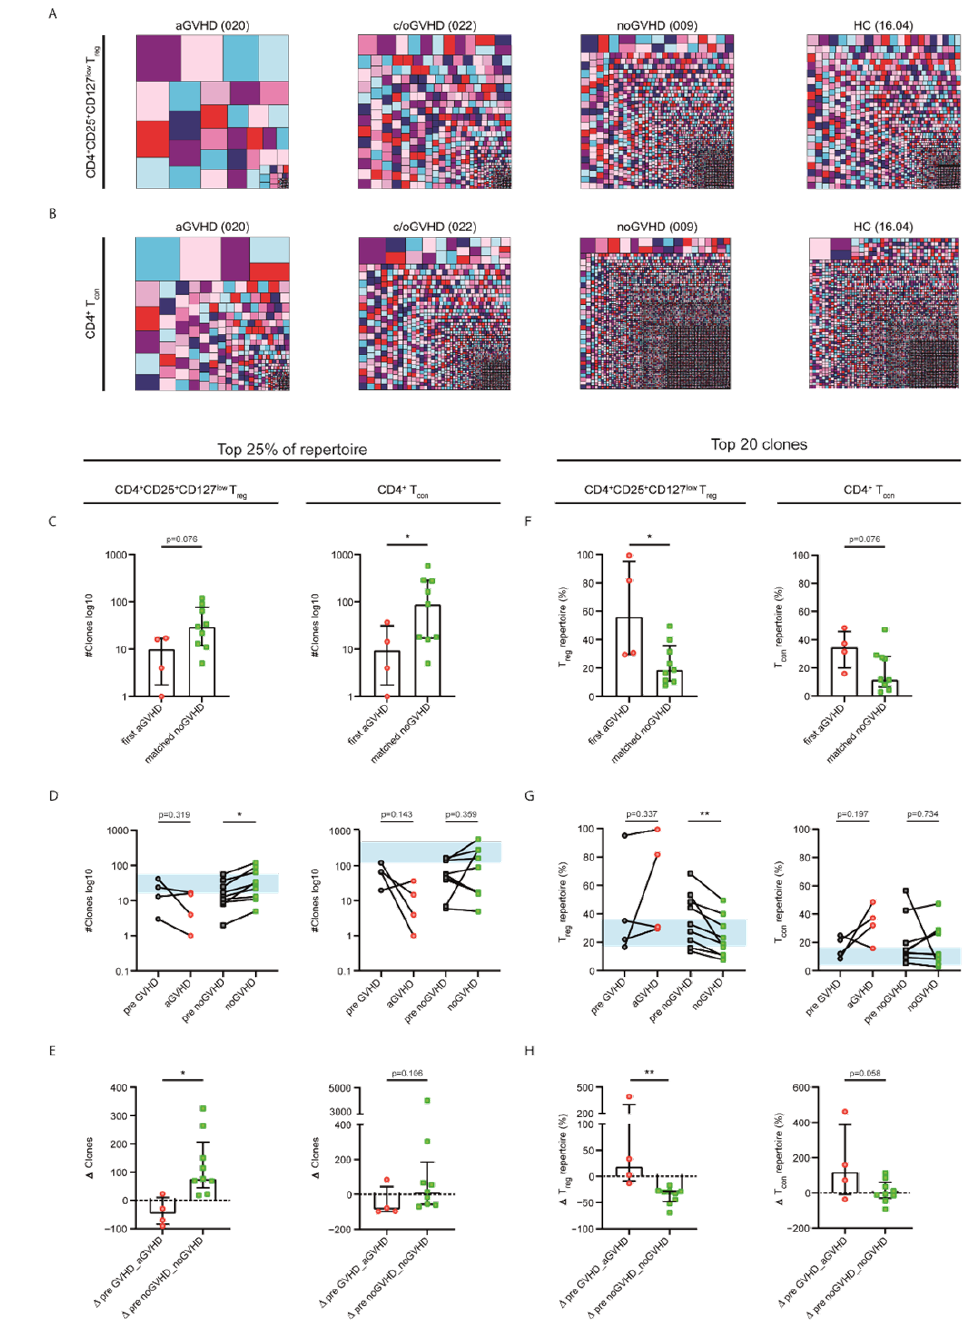
Figure 4. Increased clonality in the CD4 + CD25 + CD127 low T reg and CD4 + T con compartments is Figure 4 associated with aGVHD . ( A , B ) Tree maps visualizing the CD4 + CD25 + CD127 low T reg ( A ) and the CD4 + T con ( B ) repertoire proportions of four representative patients for aGVHD, c/oGVHD, noGVHD and healthy controls (patient IDs in parentheses). Each clone is represented by a randomly colored square with its size representing the individual clone’s proportion to the repertoire. Repetitive colors do not represent identical clones. ( C ) Numbers of unique clonotypes (y-axis) required to occupy 25% of the CD4 + CD25 + CD127 low T reg and the CD4 + T con repertoires in patients with the first occurrence of aGVHD (red circles; n = 4) compared with matched noGVHD (green squares; n = 9) samples. ( D ) Comparison of changes in numbers of unique clonotypes required to occupy the top 25% of the repertoires between the last time point prior to onset of aGVHD (pre GVHD; gray circles) and the